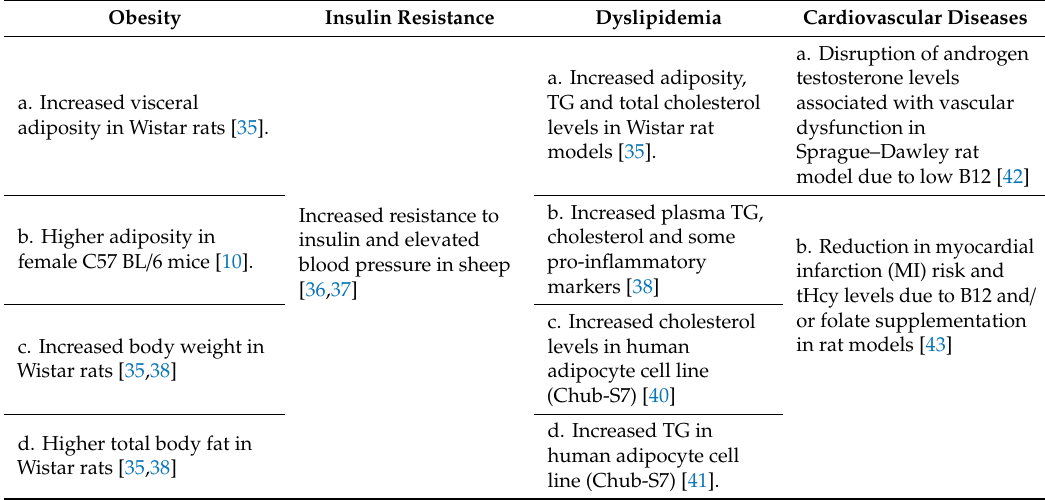
Table 2. The e ff ect of low B12 on components of cardiometabolic risk in pre-clinical studies.